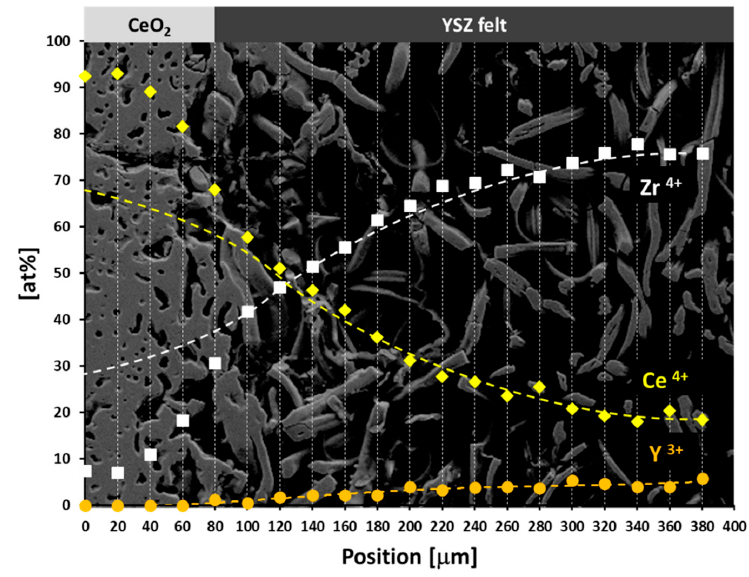
Figure 9. SEM cross-section of a CeO 2 powder compact/YSZ felt diffusion couple after thermal treatment at 1923 K with superposed EDS quantification data of line scans indicated by dashed lines.